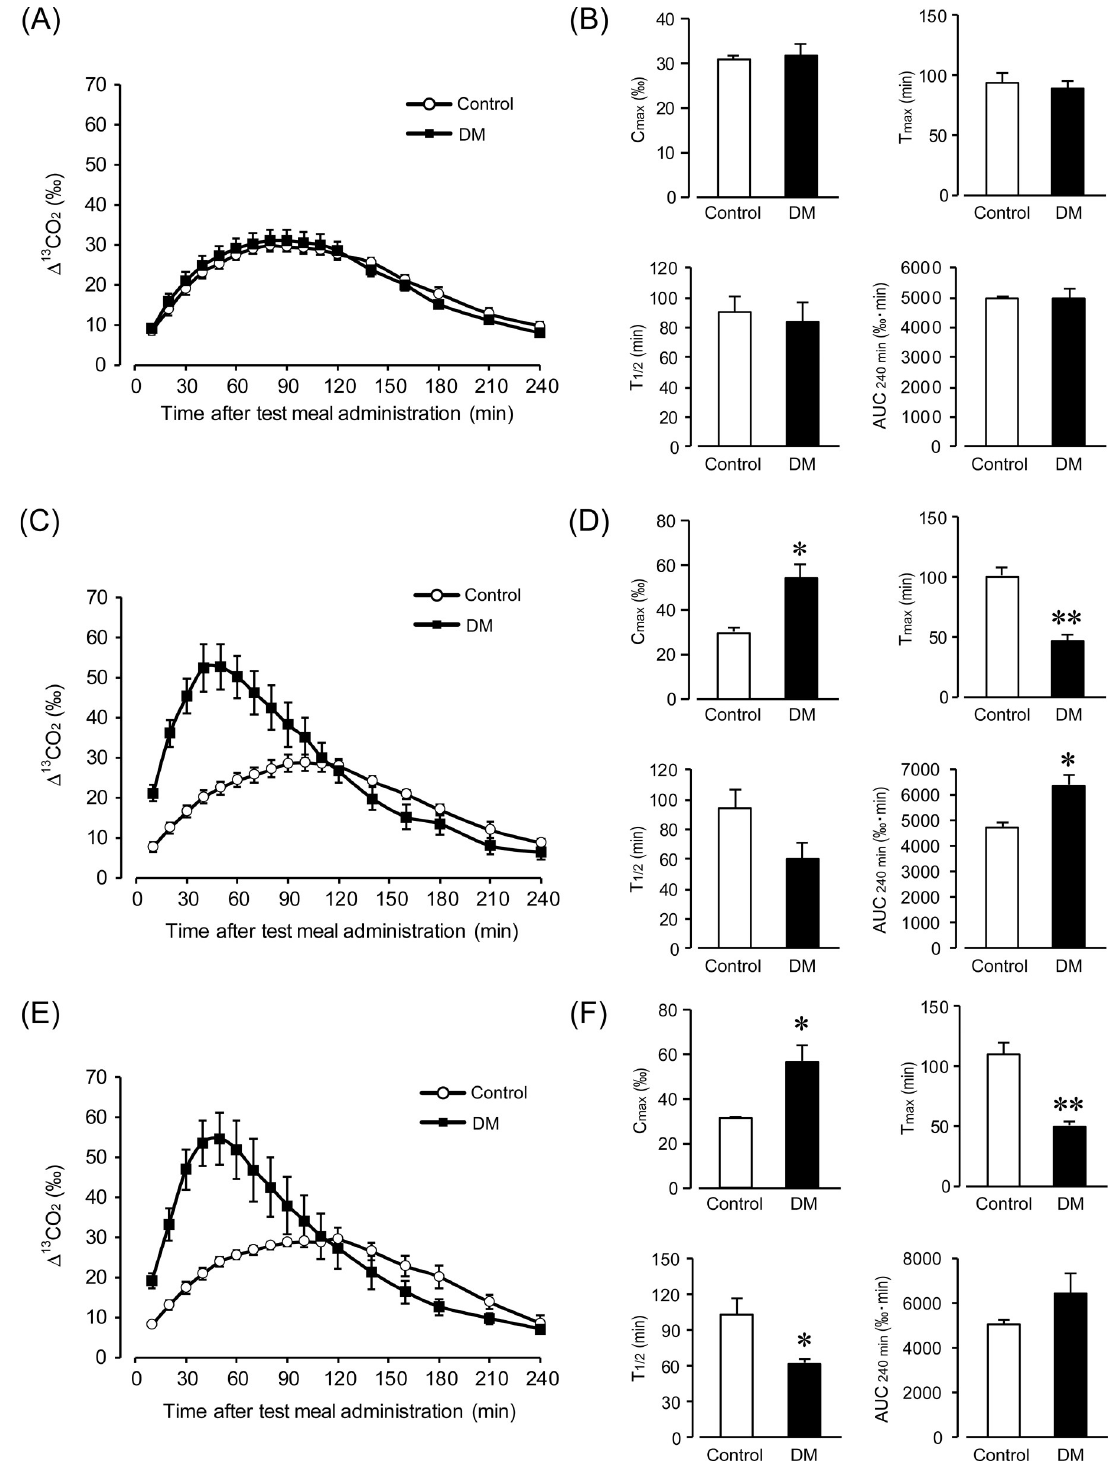
Fig 2. Accelerated gastric emptying in the early stage of type 1 diabetes. (A) and (B) Time-course of gastric emptying at 0 week following an injection of streptozotocin (STZ) in control and diabetic (DM) mice. Quantification of C max , T max , AUC 240min , and T 1/2 are calculated from (A). Each column shows the mean ± SEM (n = 5). (C) and (D) Time-course of gastric emptying, C max , T max , AUC 240min , and T 1/2 at 2 weeks following an injection of STZ in control and DM mice. Each column shows the mean ± SEM (n = 5). � P < 0.05, �� P < 0.01; significantly different from control. (E) and (F) Time-course of gastric emptying, C max , T max , AUC 240min , and T 1/2 at 4 weeks